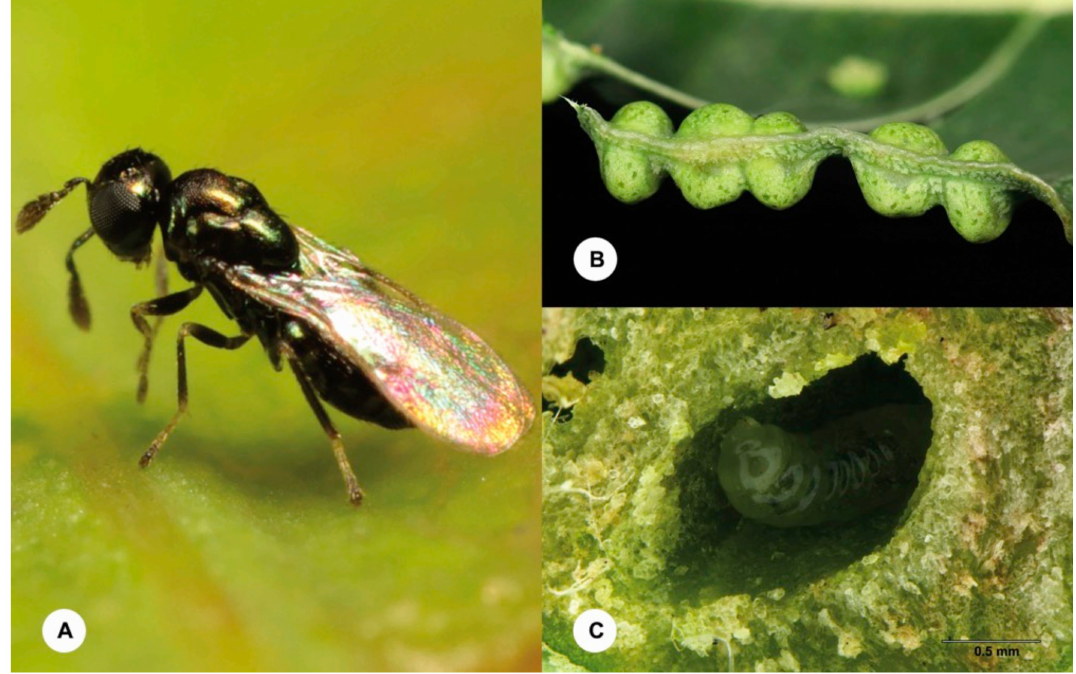
Figure 2. ( A ) A female of Ophelimus bipolaris sp. n. on the young leaf of Eucalyptus urophylla S. T. Blake. ( B ) Mature galls on the leaf edge of E. urophylla , lateral view ( C ) A mature gall on the leaf of E. urophylla cut open to show the larva of Ophelimus bipolaris sp.